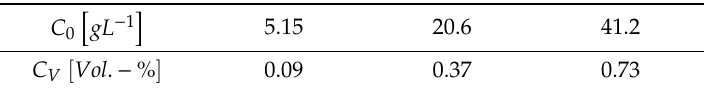
Table 1. The initial mass concentrations in the range of 5.15 gL − 1 < C 0 < 41.2 gL − 1 from the sedimentation experiment in Figure 3a are compared to their associated solid volume concentrations C V calculated using Equation